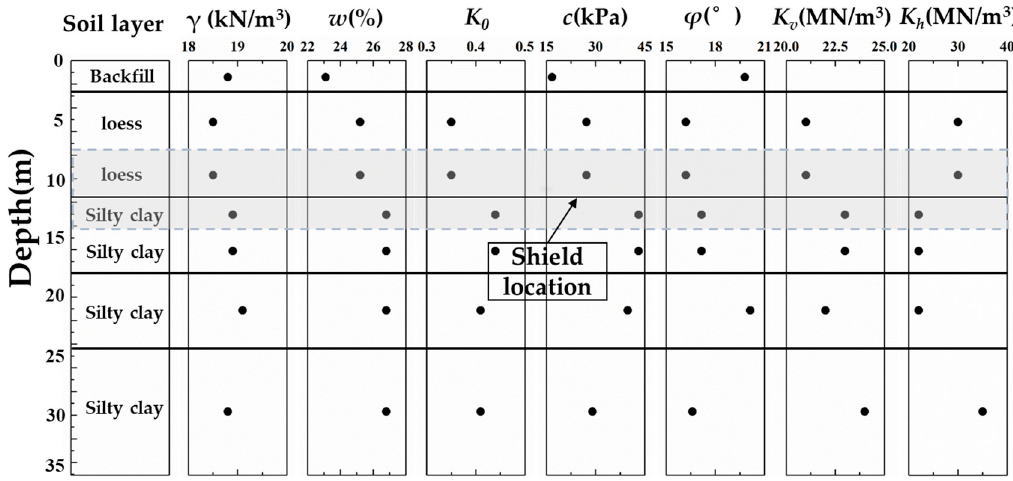
Figure 15. Geotechnical profiles of Ring 504. γ , weight density; ω , water content; K 0 , later pressure coefficient; c , cohesion; φ , internal friction angle; K v , vertical foundation coefficient; K h , horizontal foundation coefficient.